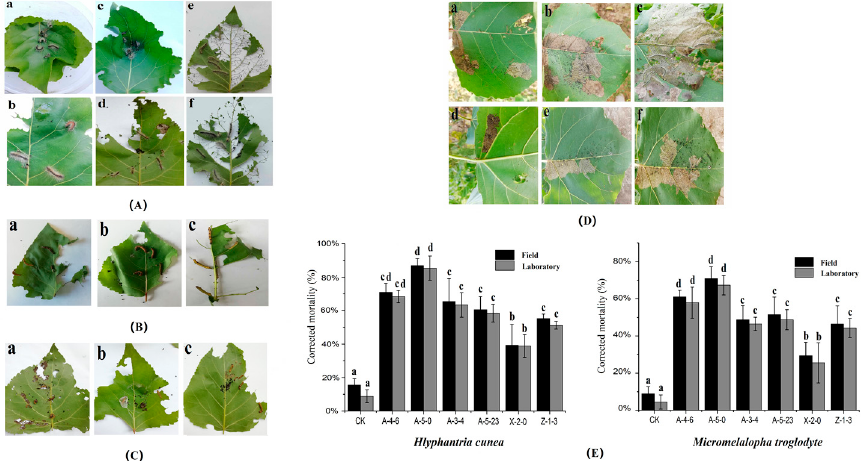
Figure 5. E ff ects of transgenic poplar on target insects. ( A ) Growth of H. cunea on days 8 ( a ) and 14 ( b ) of feeding on A-5-0 poplar, on days 8 ( c ) and 14 ( d ) of feeding on A-4-6 poplar, and on days 8 ( e ) and 14 ( f ) of feeding on control (CK) poplar. ( B ) Growth of M. troglodyta on day 10 of feeding on A-5-0 poplar ( a ), A-4-6 poplar ( b ), and CK poplar ( c ). ( C ) Growth of C. anachoreta on day 10 of feeding on A-5-0 poplar ( a ), A-4-6 poplar ( b ), and CK poplar ( c ). ( D ) E ff ects on H. cunea fed with control poplar for 2 ( a ), 4 ( b ), and 8 ( c ) days and with A-5-0 poplar for 2 ( d ), 4 ( e ), and 8 ( f ) days in the field. ( E ) Insect resistance exhibited by transgenic lines against H. cunea and M. troglodyta under field and laboratory conditions. According to Tukey’s Honestly Significant Di ff erence Test, the letters indicate